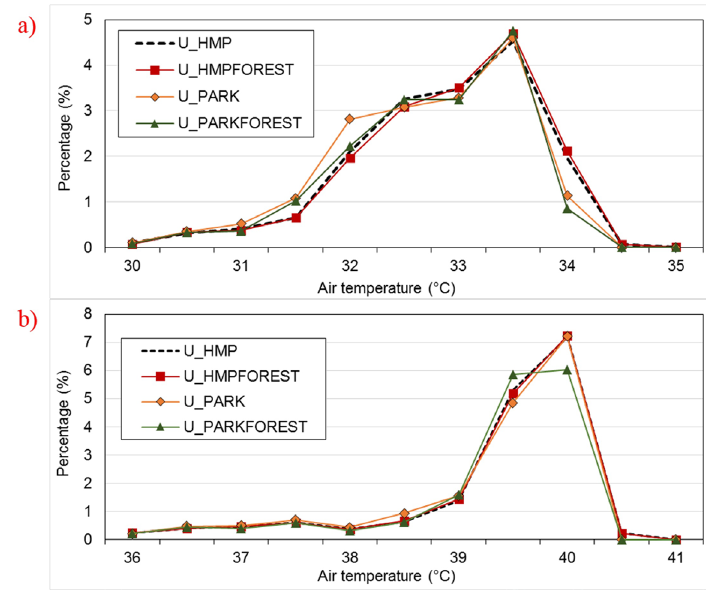
Figure 9. Air temperature distribution over the built-up areas on 17 June at ( a ) 1:00 and ( b ) 16:00. The y -axis represent the percentage of built-up area to the total simulated areas in domain